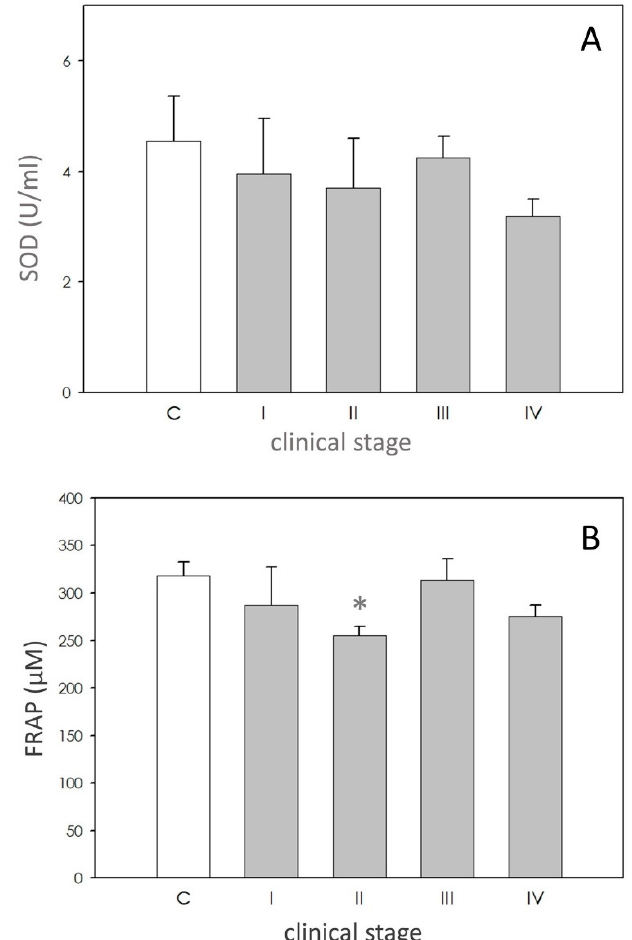
Figure 2. Scavenging activity. Panel ( A ): superoxide dismutase (SOD) activity expressed as units/mL (U/mL). Panel ( B ) ferric reducing-antioxidant power (FRAP) levels expressed as μ M. In each panel, asterisk (*) on the bar indicate significant difference ( p < 0.05) as assessed by ANOVA and Scheffè F test.